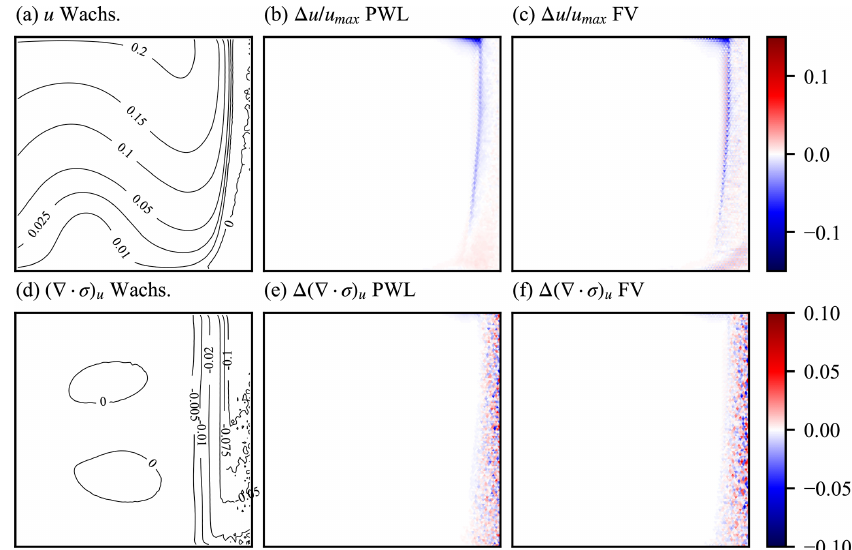
Figure 13. (a) The u velocity component of MPAS-Seaice with the Wachspress variational scheme for the square domain test case using hexagonal elements. (b, c) Difference ( (cid:49)u/u max ) between the u component of MPAS-Seaice using the Wachspress variational scheme and MPAS-Seaice using the PWL variational and finite-volume (FV) schemes, respectively, in the square domain test case using hexagonal cells. (d) – (f) As (a) – (c) but for the u component of the divergence of internal ice stress.